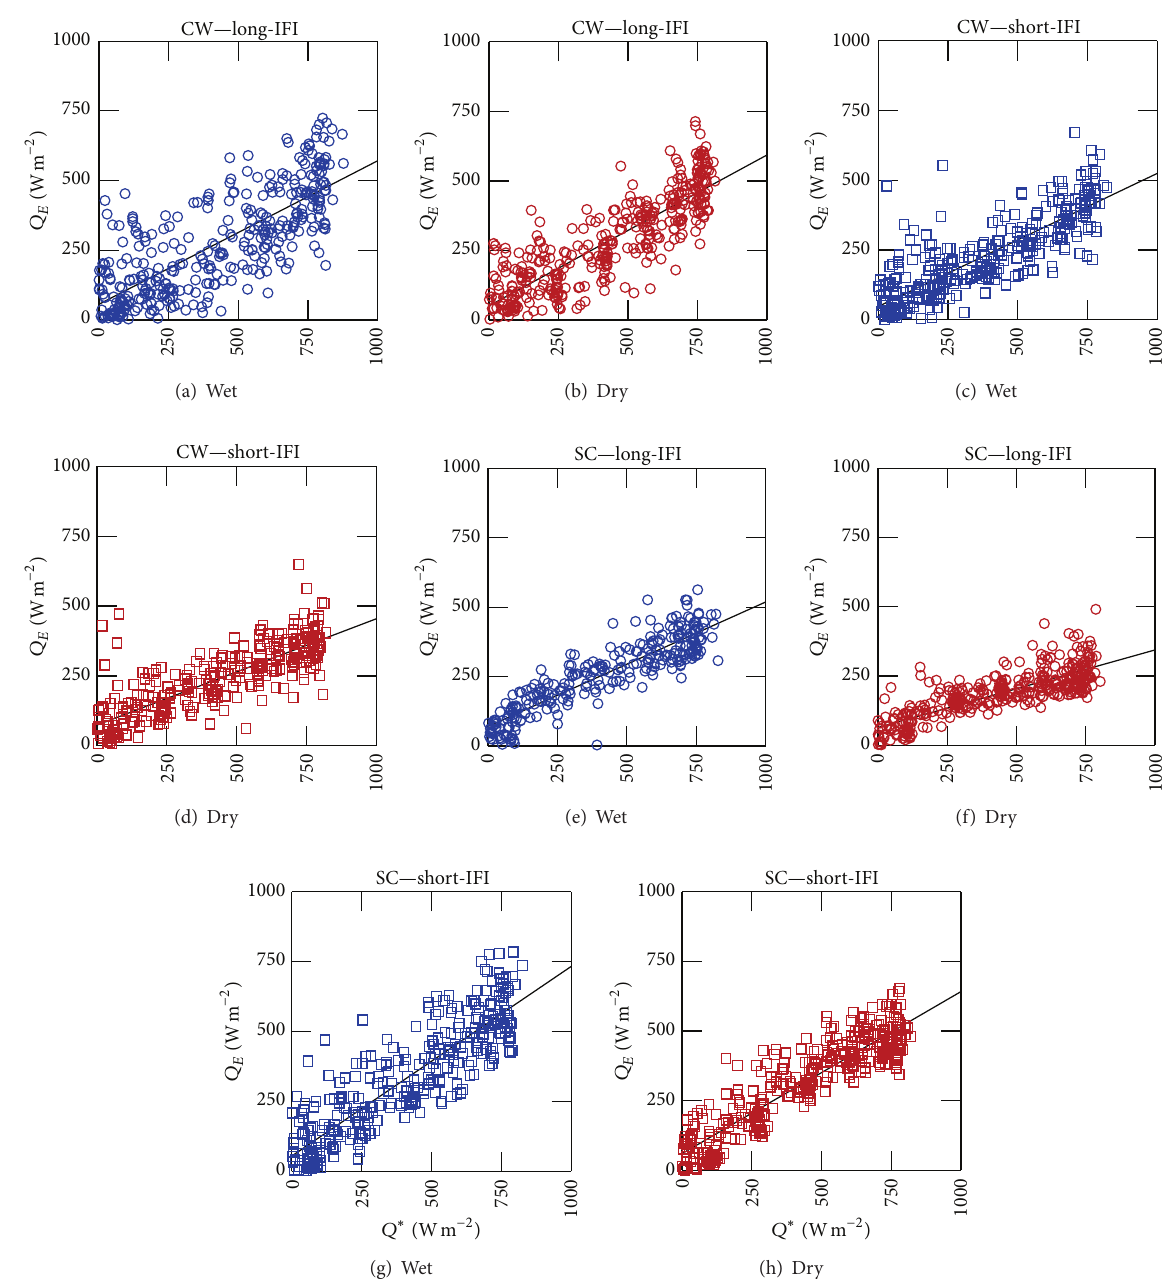
Figure 7: Evaporative fraction and the linear relationships between latent heat flux ( 𝑄 𝐸 ) and net radiation ( 𝑄 ∗ ).